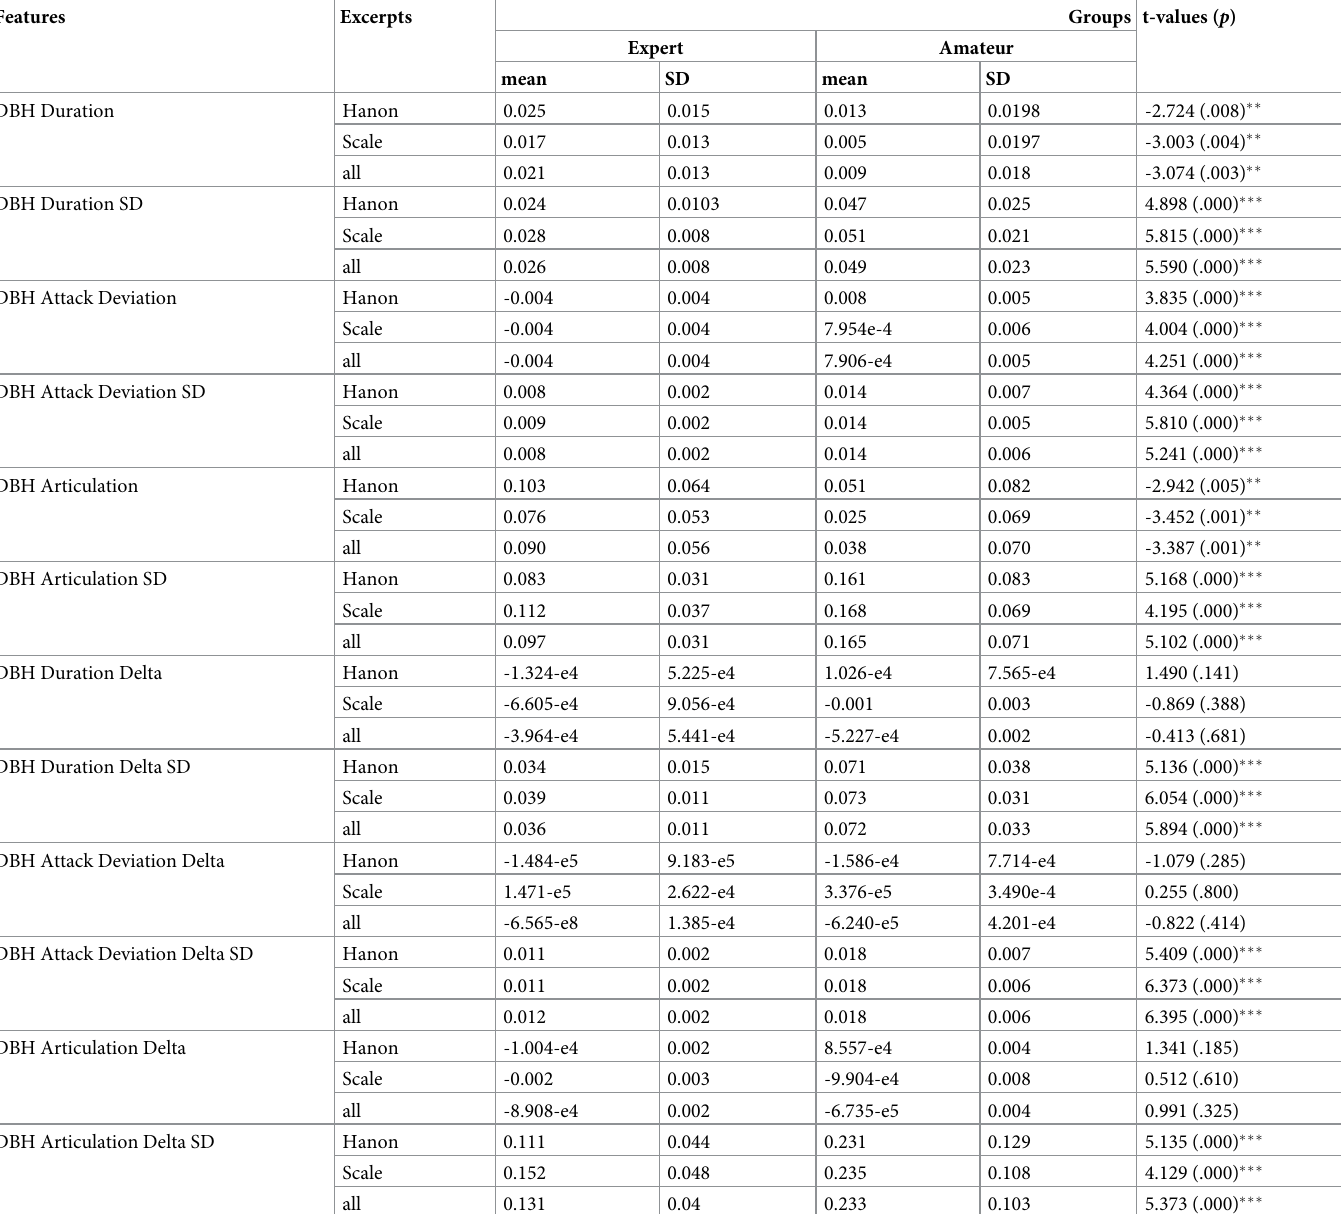
Table 3. Independent t-test statistics and p -value of the two groups (expert and